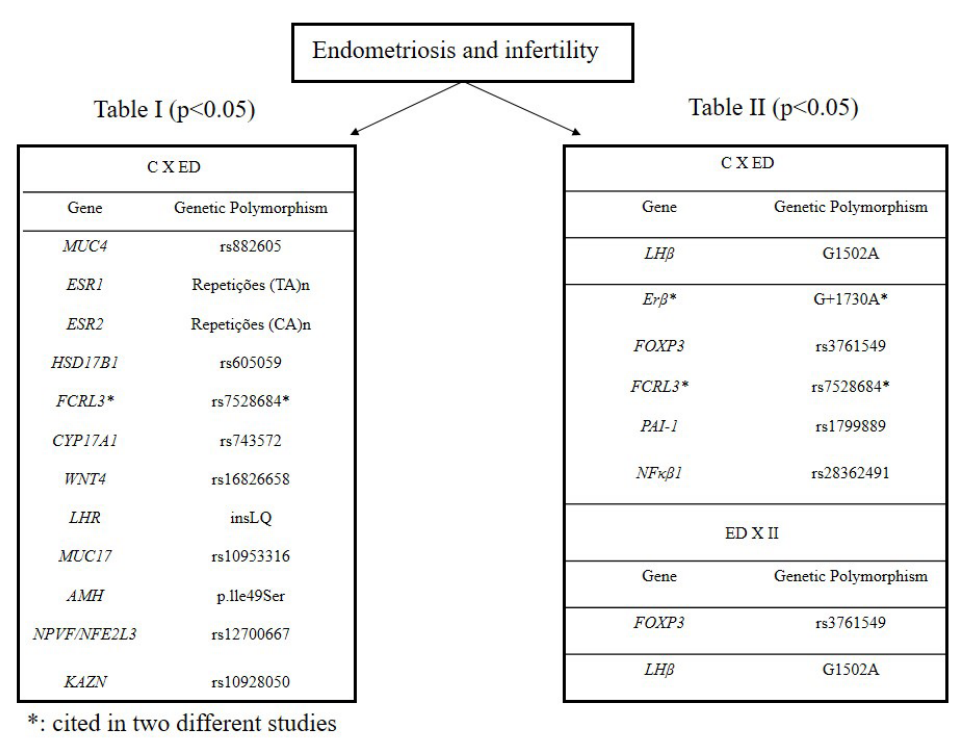
Figure 2. Genes and their respective polymorphisms that exhibited statistically significant values with